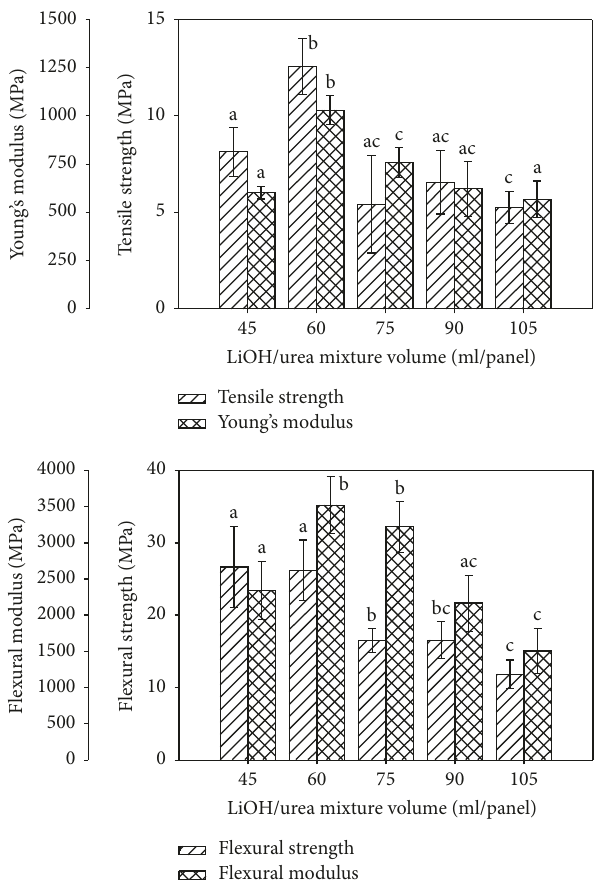
Figure 4: Effect of LiOH ⋅ H 2 O/urea solvent volume on mechanical properties of panels composed of 10g 25% cotton: 75% OOW/AF. Treatment values with different letters for the same mechanical test are significantly different ( 𝑝 ≤ 0.05 ) following Duncan’s Multiple Range Test